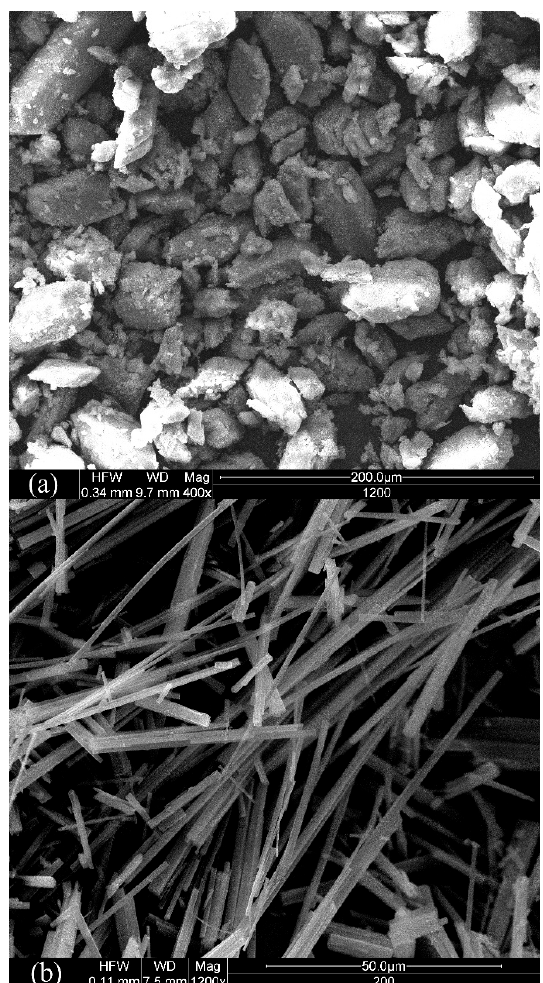
Figure 1. SEM graphs of ( a ) FGD gypsum and ( b ) CSHW derived from FGD gypsum by hydrothermal synthesis. Crystals 2017 , 7 , 270